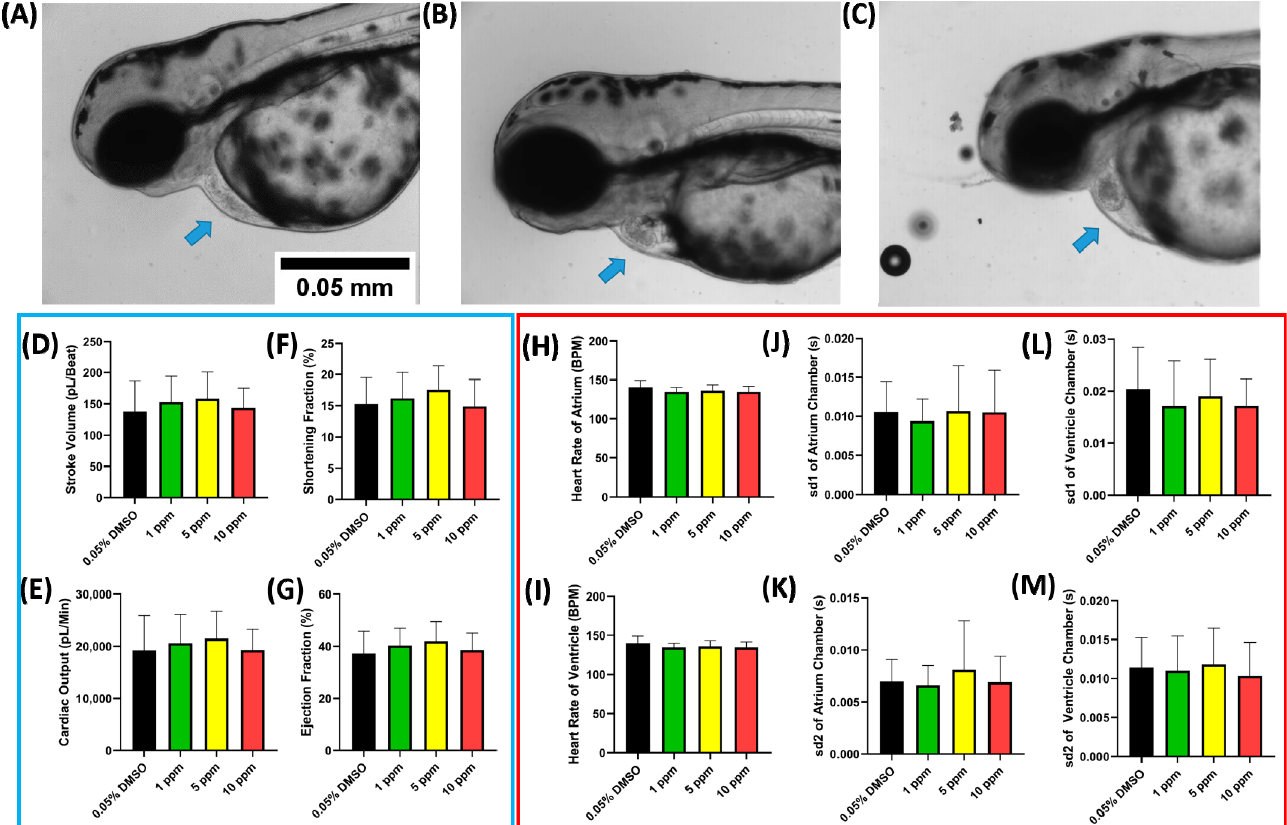
Figure 3. The morphology of 72 hpf zebrafish larvae after acute exposure in 0 ( A ), 5 ( B ), and 10 ppm ( C ) of ASC (blue arrow shows the normally developed cardiac chamber). Zebrafish cardiac physiology parameters (( D – G ), blue box) and cardiac rhythm parameters (( H – M ), red box) after exposure to ASC. Data are expressed as mean ± standard deviation, and the statistical significance was calculated using ordinary one-way ANOVA with Dunnet multiple comparison test (degree of significance was set to p < 0.05).